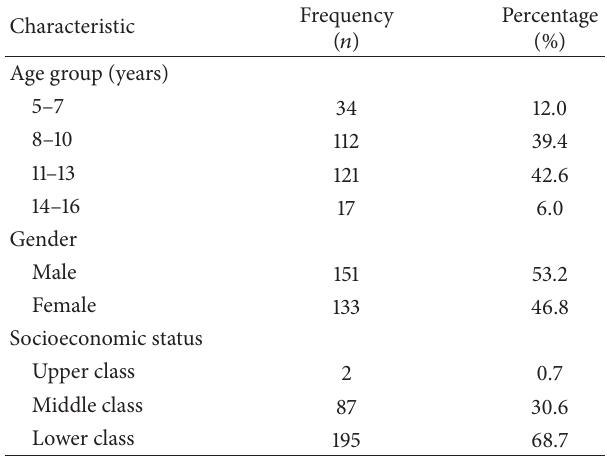
Table 1: Sociodemographic characteristics of the study